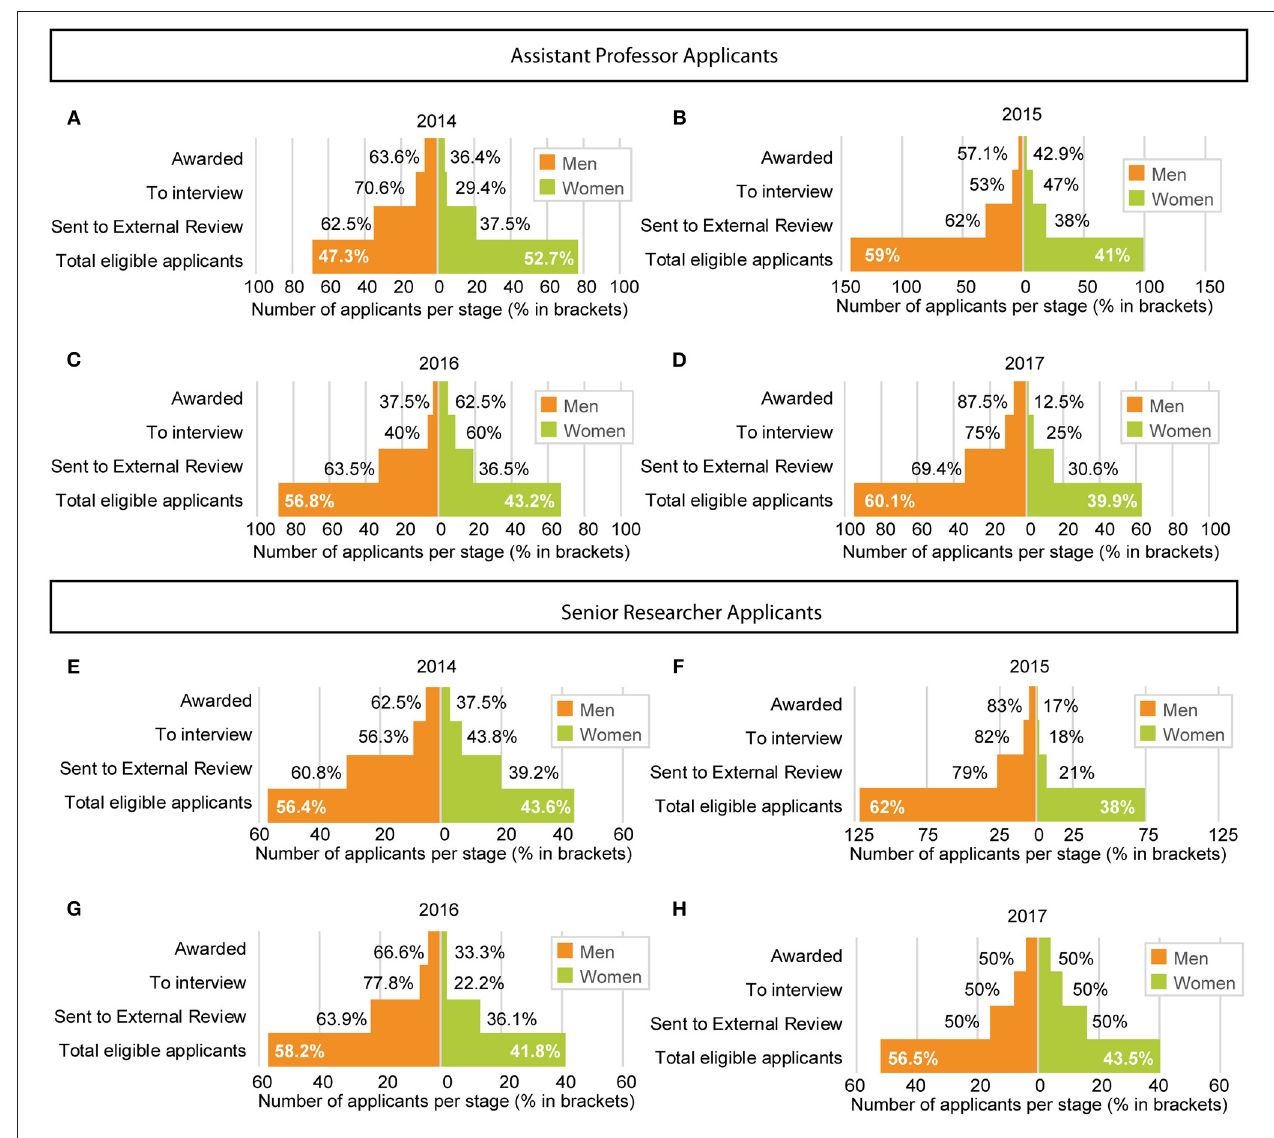
FIGURE 1 | Number of applicants and proportions at each step of the recruitment process for the career ladder positions at Karolinska Institutet, divided by each year [ (A) 2014, (B) 2015, (C) 2016, (D) 2017] for applications for assistant professor positions (A–D) or for Senior Researcher positions (E–H) . In five of the eight calls, the % of men awarded grants was higher than the % of men in the eligible applicant pool (A, D–G) .